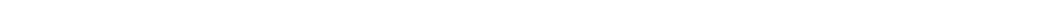
FIGURE2 and its spine apparatus. Lower left panel shows the percentages of SB and non-SB spines displaying a spine apparatus, while lower right panels show the percentages of spines projecting PSs and AdjS spinules containing a spine apparatus. (D) Spinule volume comparisons between no-CT (blue) and CT spinules (pink) (D 1 ) , between CT spinules of AdjAx (green), AdjS (yellow), and PSs origins (magenta) (D 2 ) , and between no-CT spinules of AdjAx, AdjS, and PSs origins (D 3 ) . For all boxplots, center lines show medians, box limits indicate the 25th and 75th percentiles, whiskers extend to the 5th and 95th percentiles, width of boxes is proportional to the square root of the sample size, and raw data points are plotted as filled circles. (E) Comparisons of spinule penetration distance into their SBBs between no-CT and CT spinules (E 1 ) , between CT spinules of AdjAx, AdjS, and PSs origins (E 2 ) , and between no-CT spinules of AdjAx, AdjS, and PSs origins (E 3 ) . (F) Comparisons of the percentage of SBB volume occupied by no-CT and CT spinules (F 1 ) , CT spinules of AdjAx, AdjS, and PSs origins (F 2 ) , and no-CT spinules of AdjAx, AdjS, and PSs origins (F 3 ) . Scale bars (B,C) 0.5 µ m; Scale cubes (B,C) 0.5 µ m per